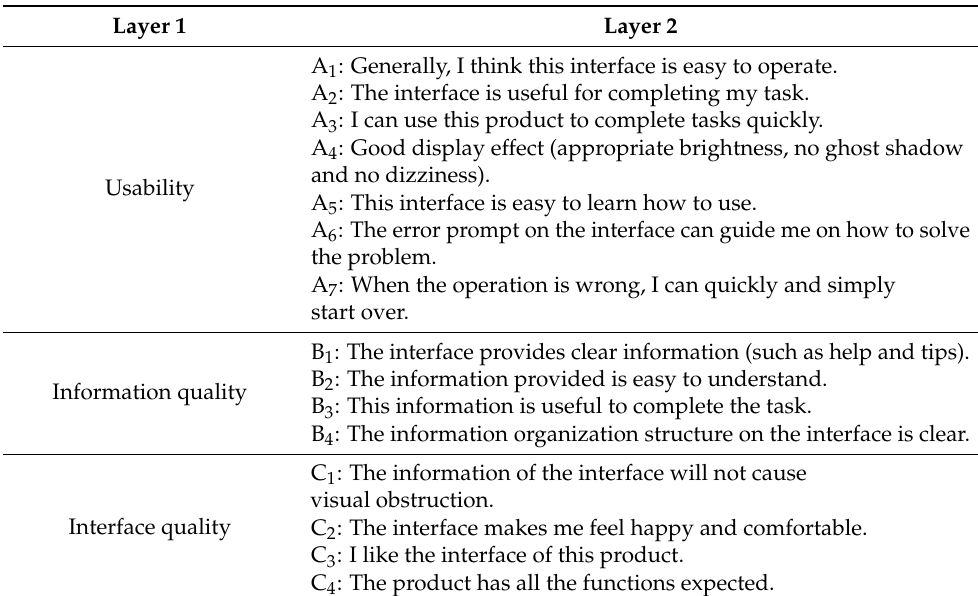
Table 1. In-vehicle HUD interface design evaluation indicator